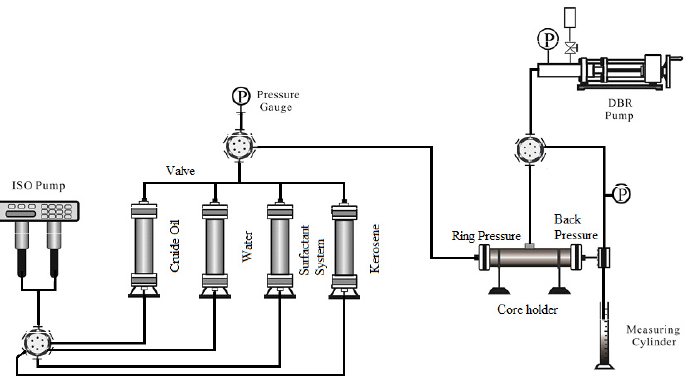
Figure 2. Schematic diagram of water flooding and surfactant flooding experiments.